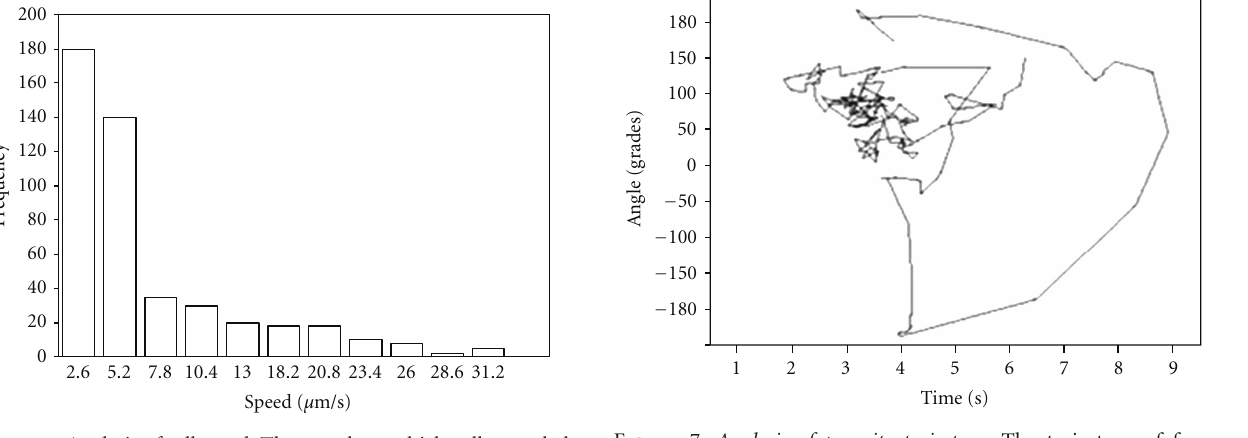
Figure 5: Analysis of cell speed . The speeds at which cells traveled through consecutive points during 1-sec time intervals were quan- tified in CFSE green fluorescent-labeled epimastigotes. The his- togram is representative of the average behavior of 20 randomly selected epimastigotes.